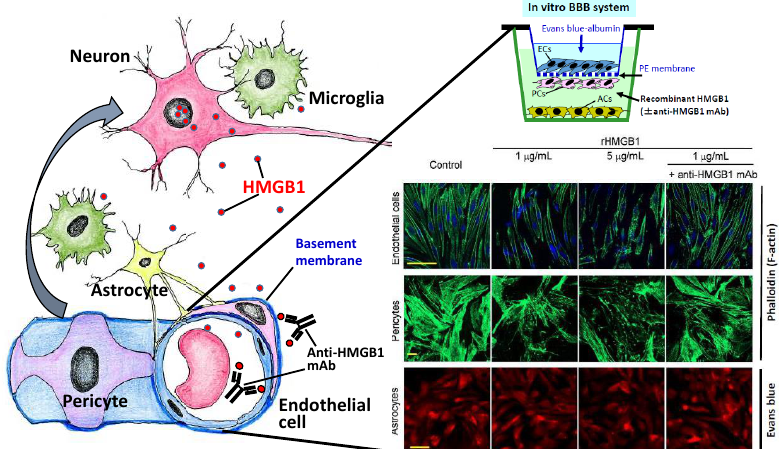
Figure 3. Direct effects of HMGB1 on vascular endothelial cells and pericytes. A rat-reconstituted BBB system composed of vascular endothelial cells, pericytes, and astrocytes (upper right) was used. Recombinant HMGB1 at 1 or 5 mg/mL was added to the brain side (lower chamber), and the incubation was continued for 60 min. After 1 h of stimulation with HMGB1, the cells were fixed with paraformaldehyde. Endothelial cells and pericytes were labeled with Alexa-488-phalloidin, and the astrocytes were labeled with Evans blue. The contractile response was observed in endothelial cells and pericytes, which were inhibited by the presence of specific anti-HMGB1 mAb in the lower chamber (modified from Zhang et al., [15]). BBB: blood–brain barrier; HMGB1: high mobility group box-1; mAb: monoclonal antibody.